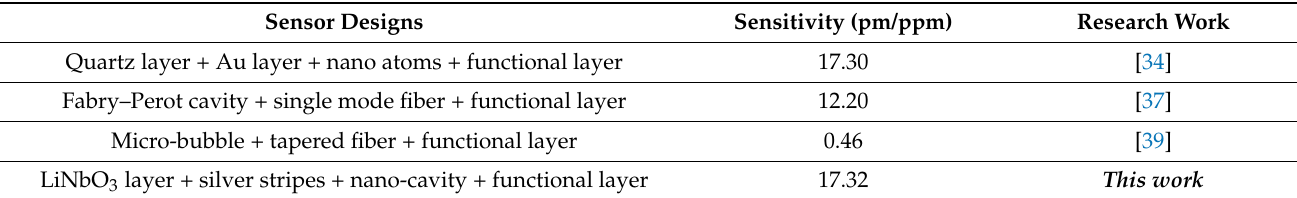
Table 4. Comparative study of the research with previously investigated studies.